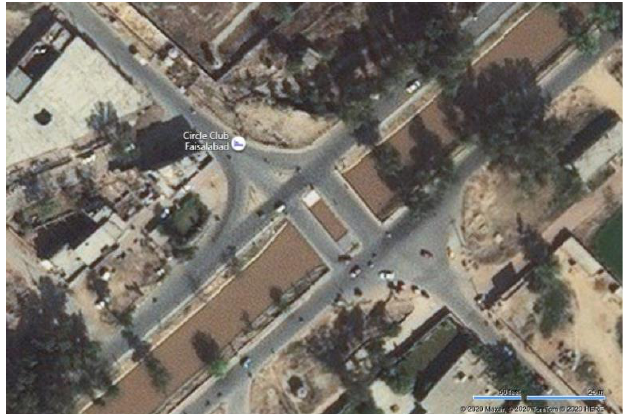
Figure 3: Pre-project construction Ariel view of Kashmir bridge.